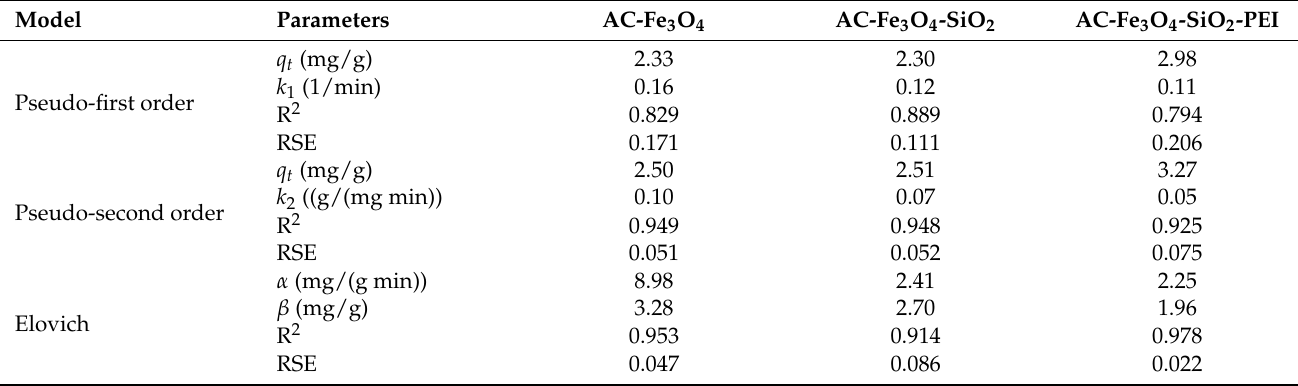
Figure 10. Kinetic modeling for the adsorption of Cr(VI) by AC-Fe 3 O 4 ( a ), AC-Fe 3 O 4 -SiO 2 ( b ), and AC-Fe 3 O 4 -SiO 2 -PEI ( c ). Table 3. Kinetics isotherm parameters of AC-Fe 3 O 4 , AC-Fe 3 O 4 -SiO 2, and AC-Fe 3 O 4 SiO 2 -PEI.